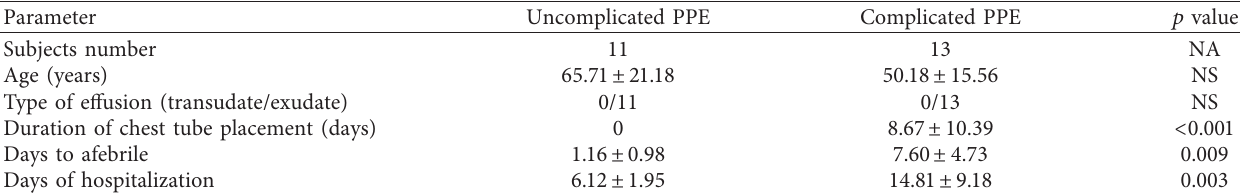
Table 1: Demographic and clinical characteristics of the study population. Data are expressed as mean ± SD or as absolute numbers. PPE, parapneumonic effusion; M/F, male/female; NA, not applicable; NS, not significant. Parameter